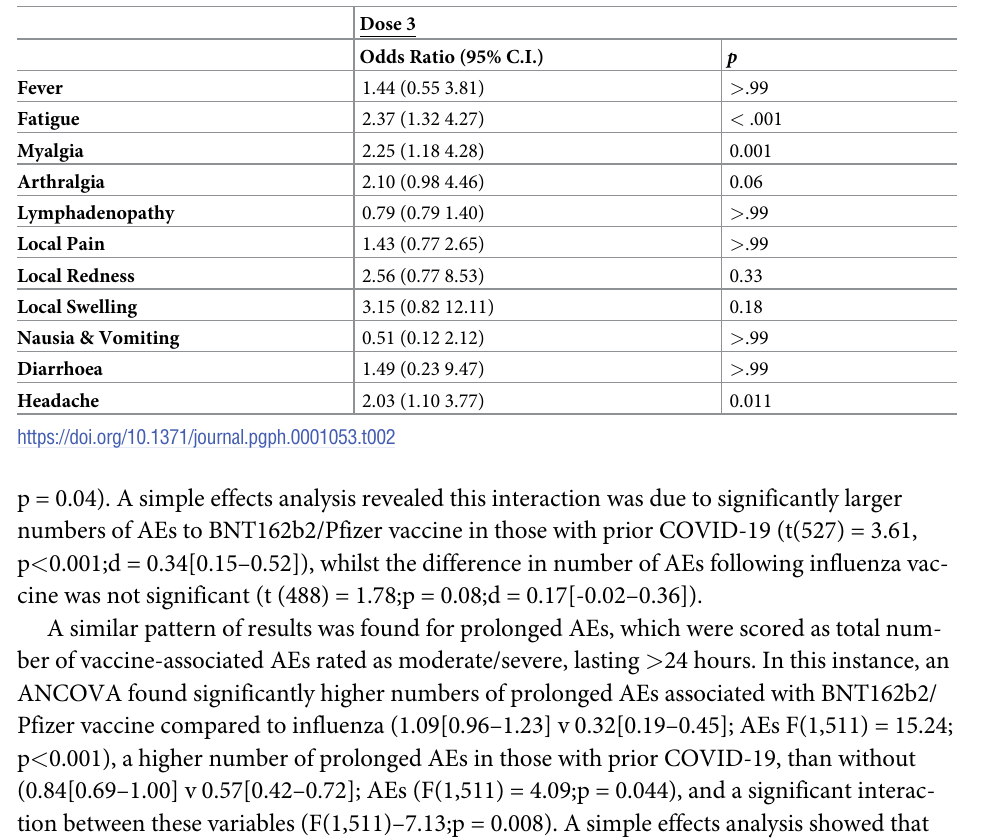
Table 2. Moderate and severe AEs by COVID-19 status: Percentage of cases reporting moderate or severe AEs fol- lowing BNT162b2/Pfizer third/booster dose (95% CI) in those with and without a history of COVID-19 (the for- mer including